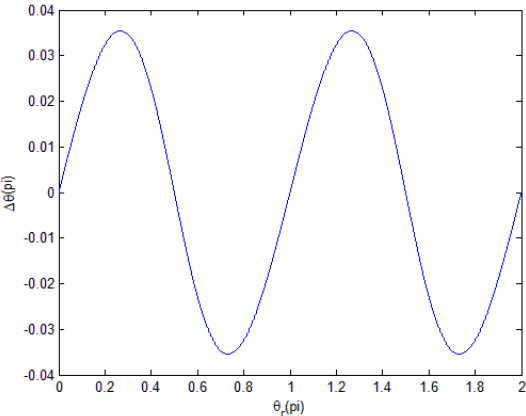
θΔ in one period of